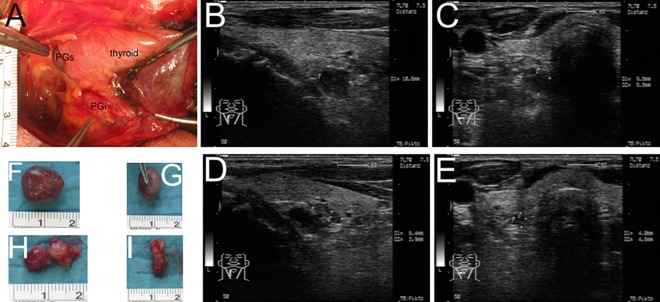
Topography and size of parathyroid glands at parathyroidectomy and ultrasound.Topography of the right-sided superior and inferior PG after luxation of the thyroid gland (A). Topography and measurement of corresponding PG by US: superior (B+C) and inferior (D+E). Volumes of PG were 479mm3 (PG superior) and 99mm3 (PG inferior) when calculated with US measurements. Documentation of PG size during surgery: superior (F+G) and inferior (H+I). Volumes of PG were 858mm3 (PG superior) and 293mm3 (PG inferior) when calculated with intra-operative measurements. PGs, superior parathyroid gland; PGi, inferior parathyroid gland.